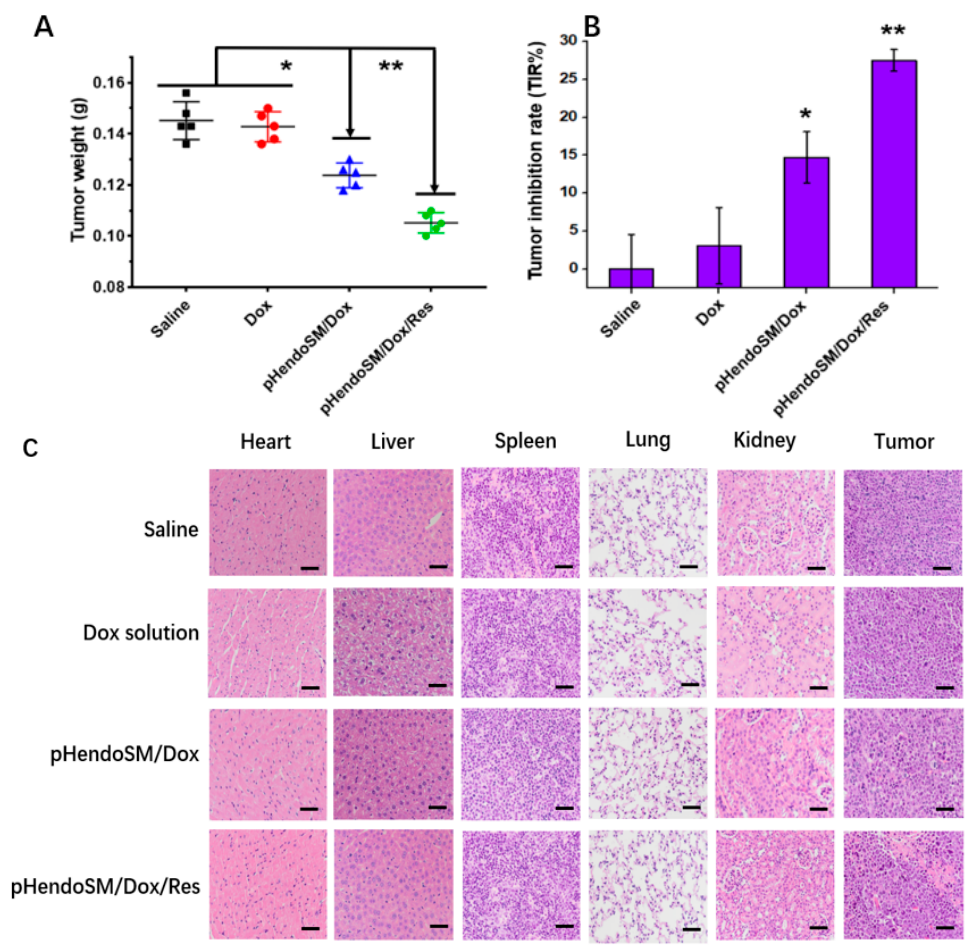
Figure 9. The tumor weight ( A ) and tumor inhibition rate (TIR%) ( B ) of MCF-7/ADR tumor-bearing nude mice at 48 h after intravenously-injected Saline, Dox solution, pH-endoSM / Dox and pH-endoSM / Dox / Res ( n = 5). * p < 0.05, ** p < 0.01 compared with the control group. Morphological evaluation in hematoxylin and eosin (H&E) sections of the major organs and tumor sites ( C ). Scale bars = 50 μ m.